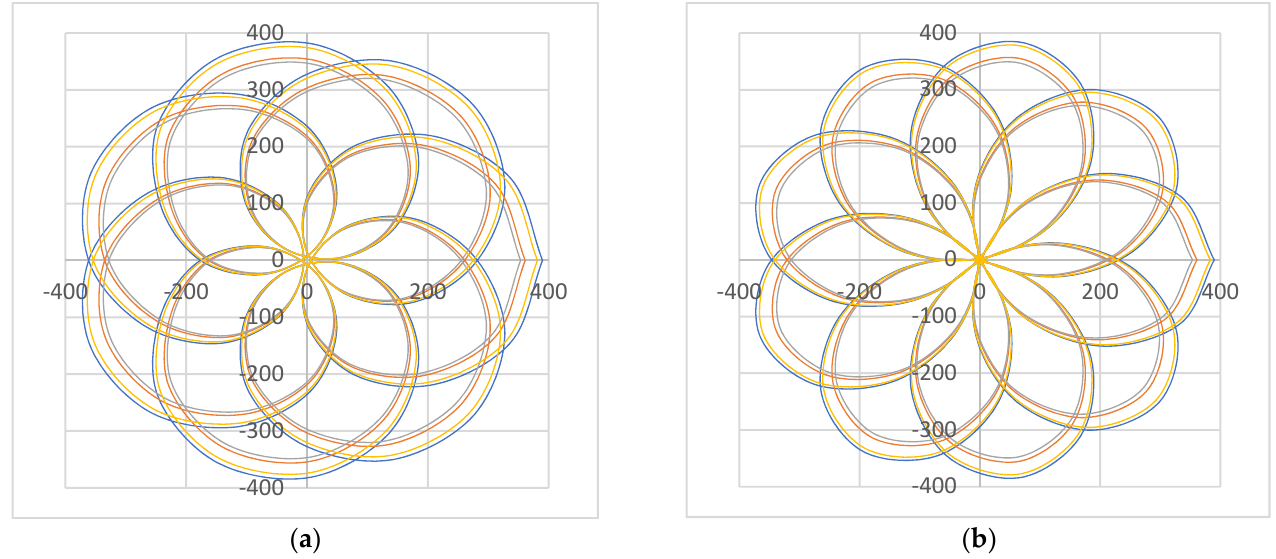
Figure 8. Comparison between the scan patterns of the four scanner configurations presented in Figure 2, for | M | = 8 and k = 1 (the latter obtained for D 1 = D 2 = 10°). ( 1 ) Left column, M > 0; ( 2 ) right column, M < 0 . The values on the axes are in millimeters.